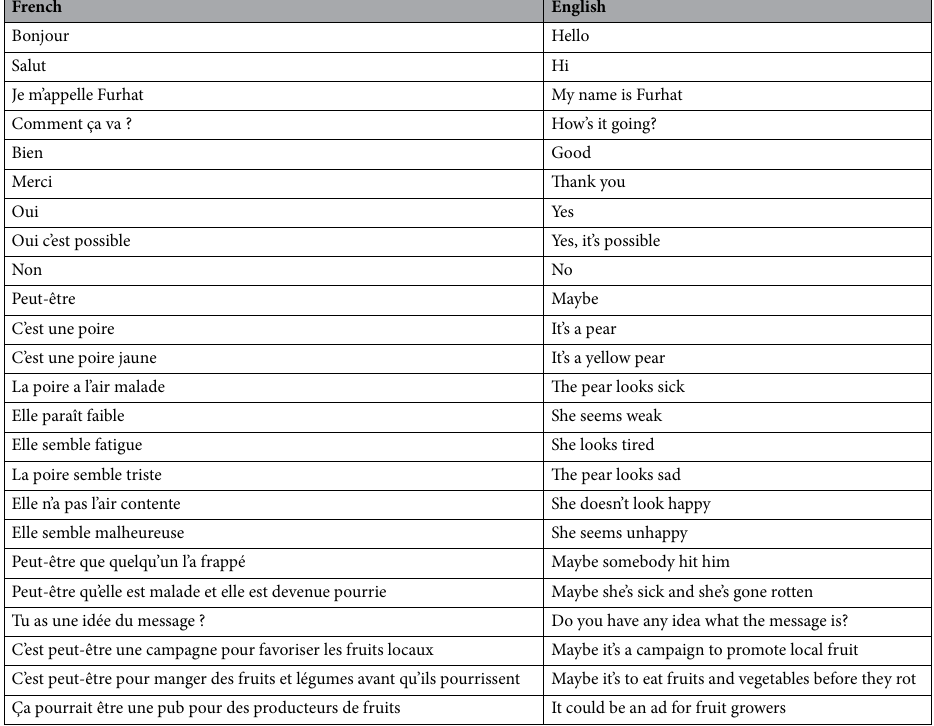
Table 1. Example of pre-recorded sentences pronounced by the robot, grouped according to their function in the conversation: presentations, generic answers, descriptions of an image (a pear in the series “rotten fruits”), and exchanges on the message of the advertising